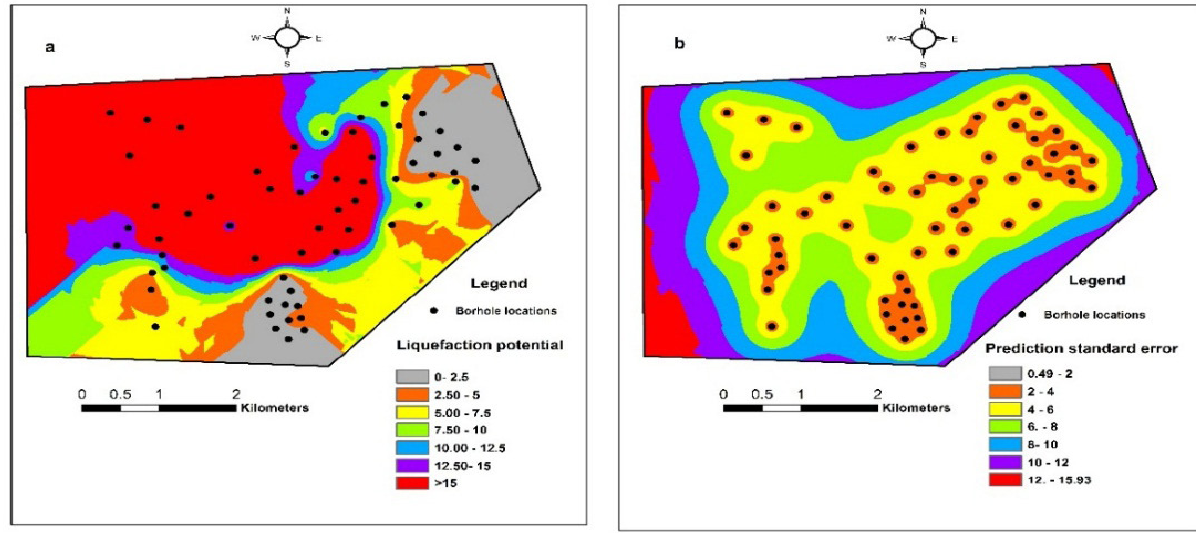
Figure 9: Liquefaction potential hazard map predicted by ordinary kriging (a) and corresponding standard deviation map (b) for earthquake magnitude of 6.8 and peak ground acceleration of 0.3 g (isotropic analysis).